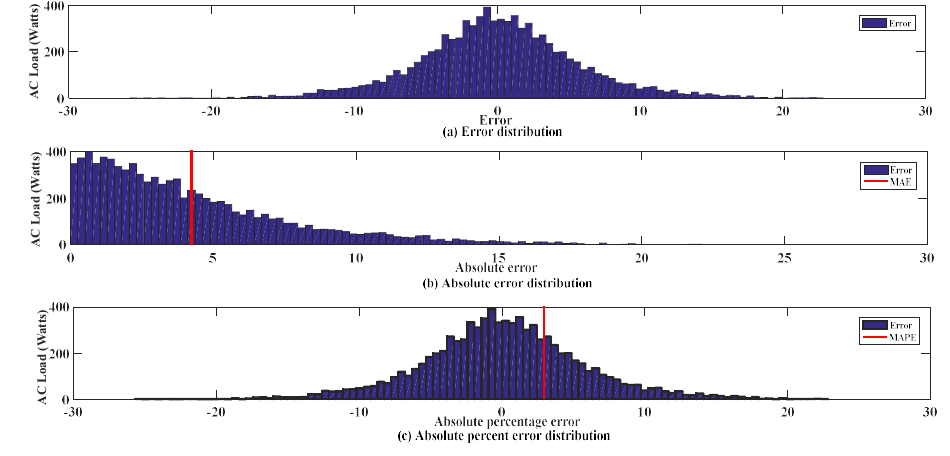
Figure 8. Error distribution histogram.